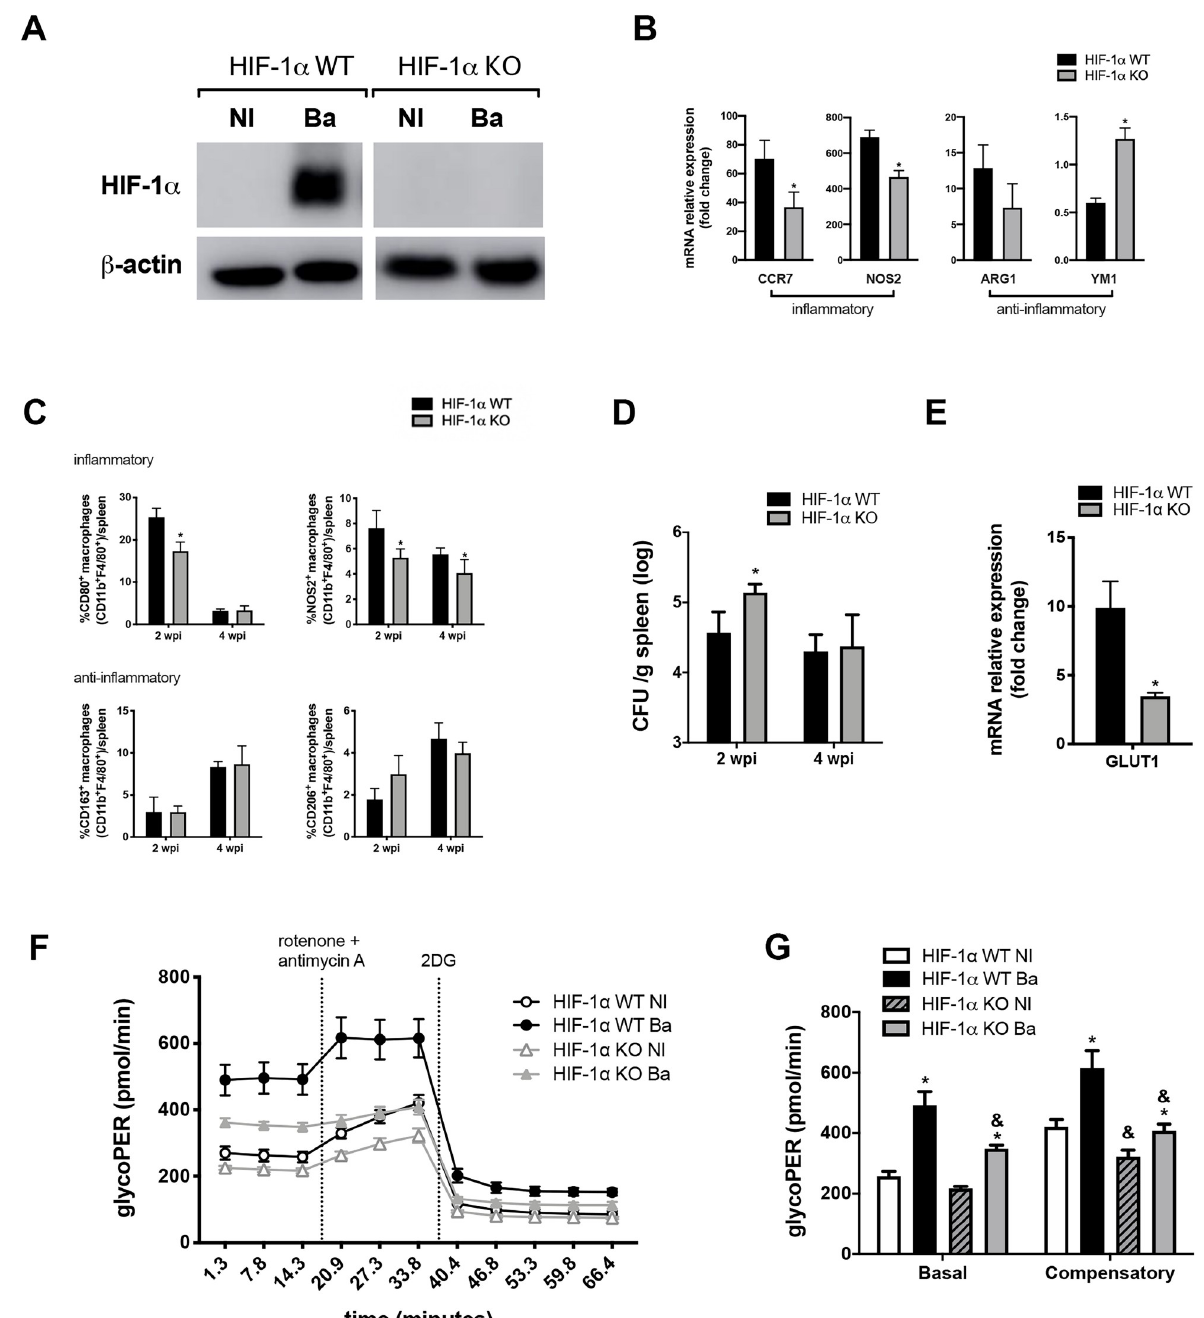
Fig 2. Metabolic reprogramming in infected macrophages requires HIF-1 α . (A) Western blot analysis of HIF-1 α in cell lysates from macrophages derived from HIF-1 α WT or HIF-1 α KO mice, non-infected (NI) or infected with B . abortus (Ba). Equal loading was controlled by measuring β - actin in the corresponding cell lysates. (B) CCR7, NOS2, ARG1, and YM1 expression levels determined by real-time RT-PCR in B . abortus -infected macrophages derived from HIF-1 α WT or HIF-1 α KO mice. (C) Frequency of CD80 + F4/80 + CD11b + , NOS2 + F4/80 + CD11b + , CD163 + F4/ 80 + CD11b + and CD206 + F4/80 + CD11b + cells measured by flow cytometry analysis in spleen cells from infected HIF-1 α WT or HIF-1 α KO mice, at 2 or 4 weeks post-infection (wpi). Representative plots of analysis are shown in S4 Fig. (D) CFU numbers in spleen homogenates of HIF-1 α WT and HIF-1 α KO mice infected intraperitoneally with B . abortus at 2 or 4 weeks post-infection (wpi). (E) GLUT1 expression levels determined by real- time RT-PCR in B . abortus infected-macrophages derived from HIF-1 α WT and HIF-1 α KO mice. (F) Time-course quantification of glycolytic proton efflux rate (glycoPER) in macrophages derived from HIF-1 α WT and HIF-1 α KO mice, non-infected (NI) or infected with B . abortus (Ba). (G) Quantification of basal and compensatory glycoPER. The data are representative of three (A-E) or two (F and G) independent experiments. The